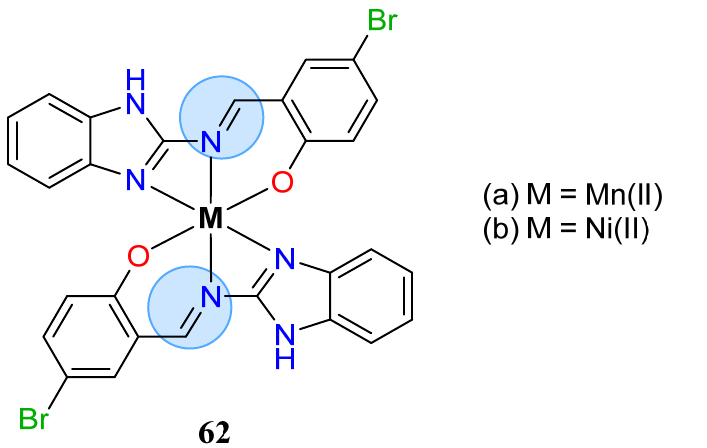
Figure 26. Mn(II) complex from ONN/OSO and ONS Schiff base ligand with antimicrobial activity.